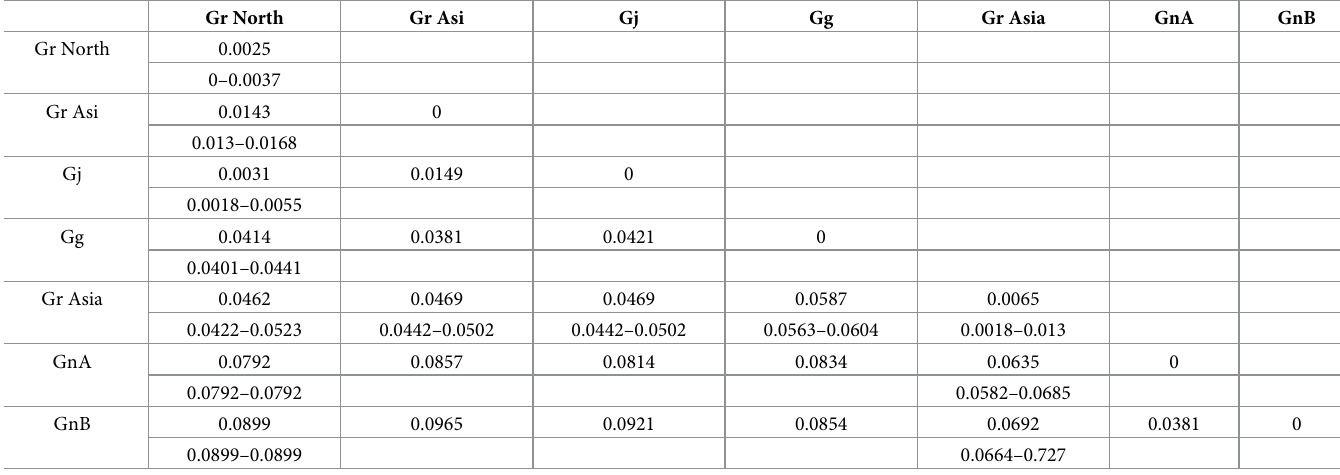
Table 3. Genetic distances between geographically separate Garra